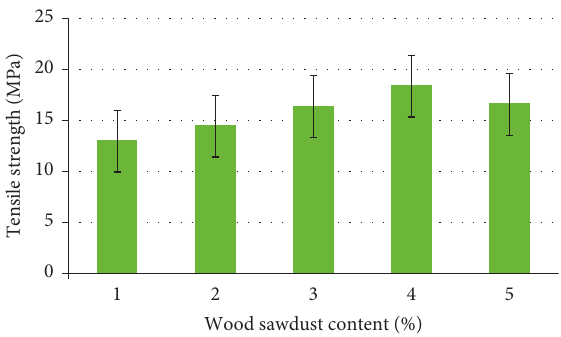
Figure 3: Effect of sawdust content on tensile